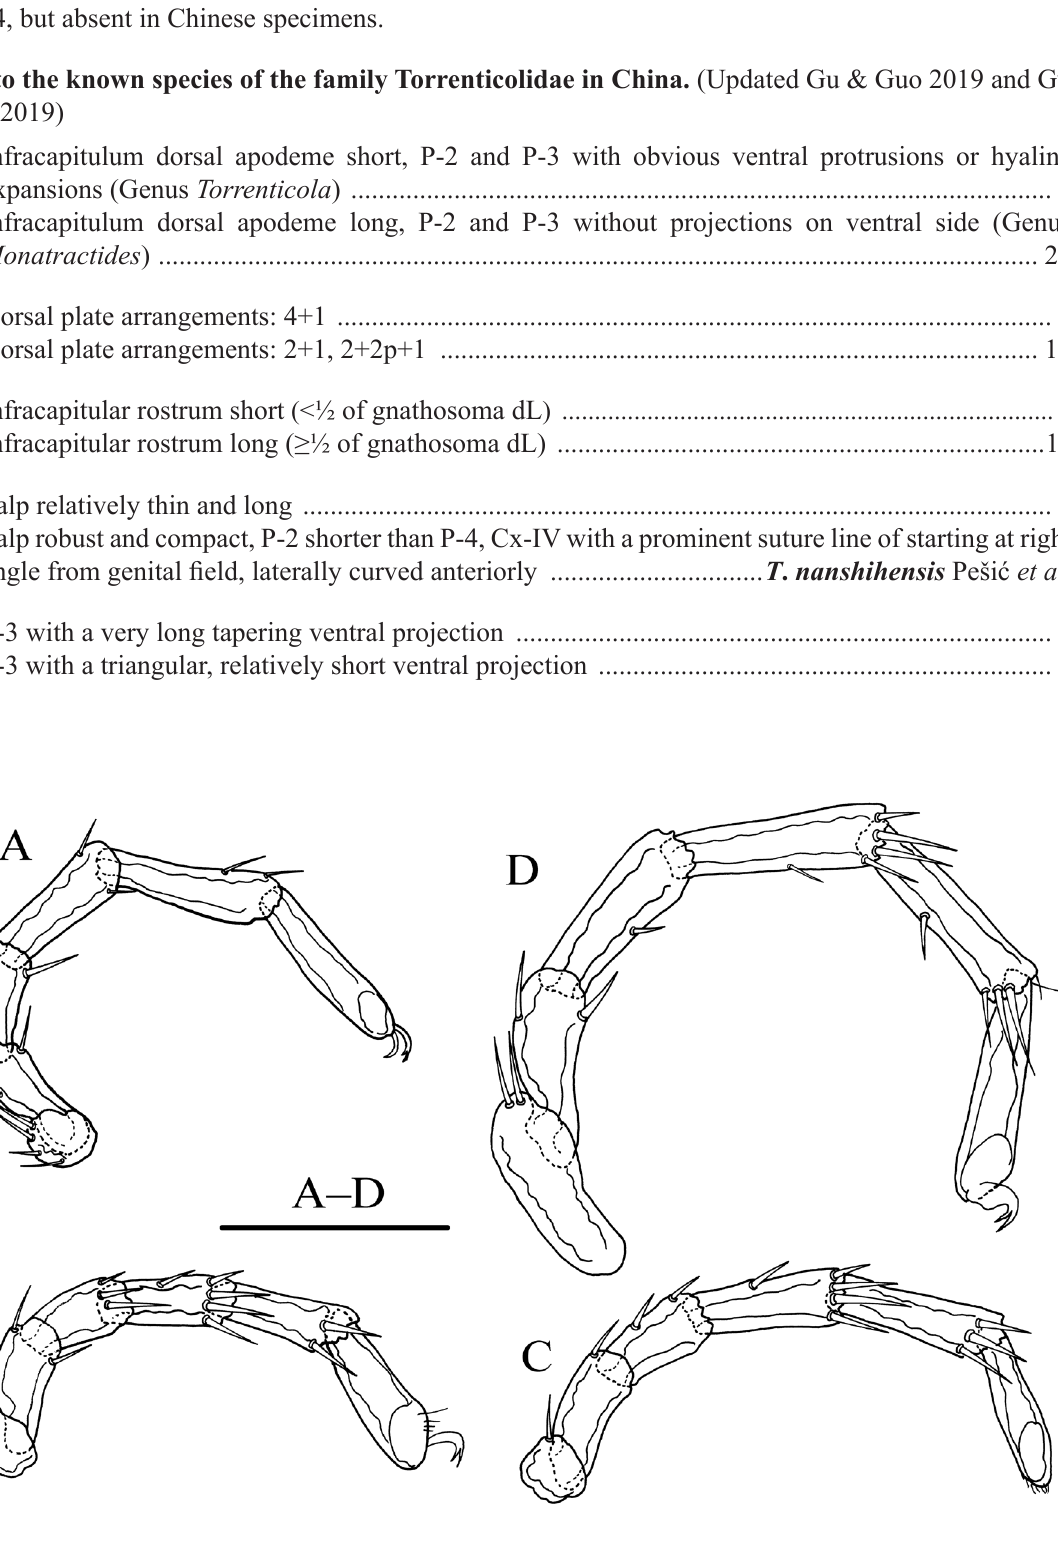
Fig. 16. Torrenticola dentifera Wiles, 1991, ♀, (FJ-TO-20180807). A . leg-I. B . leg-II. C . leg-III. D . leg- IV. Scale bar = 100